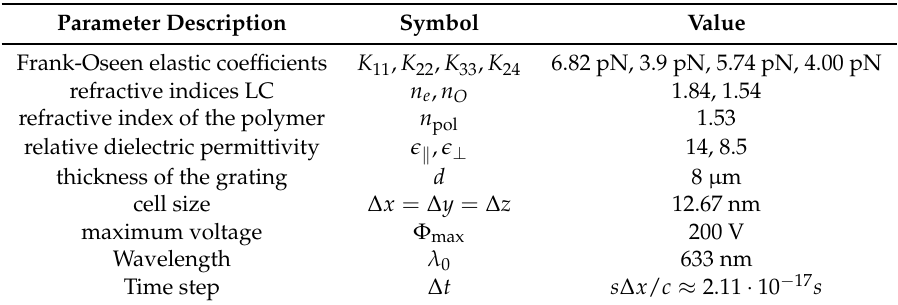
Table 1. Parameter values used for numerical